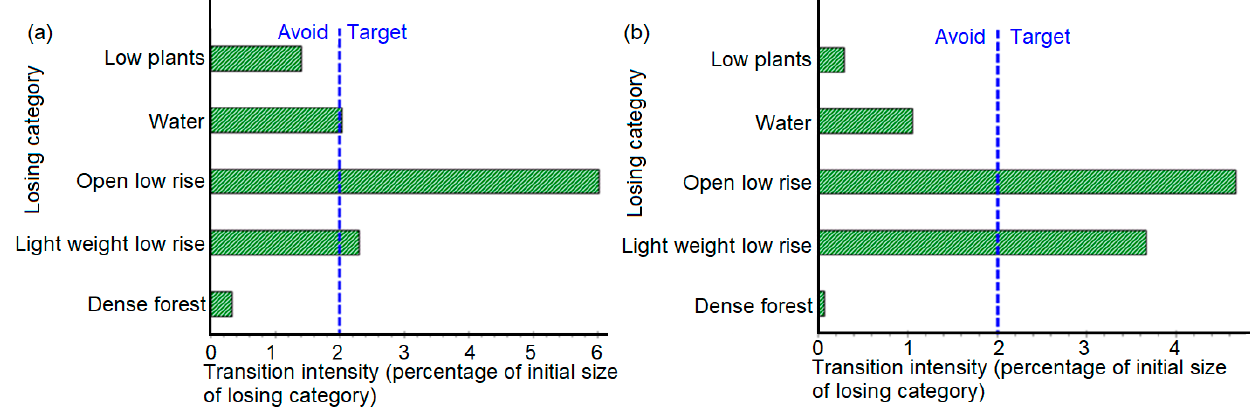
Figure 5. Transition intensity given gain of Compact low rise from ( a ) 1990 to 2005 and ( b ) 2005 to 2020.